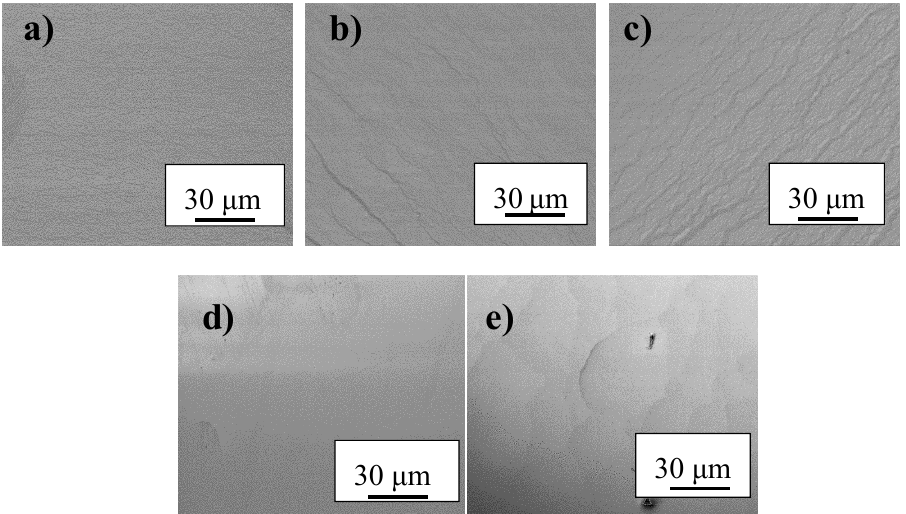
Figure 4. Surface morphology of the deposited diamond films. the methane concentration: ( a ) 3.3%; ( b ) 4%; ( c ) 5%; ( d ) 6% and ( e ) 8%.